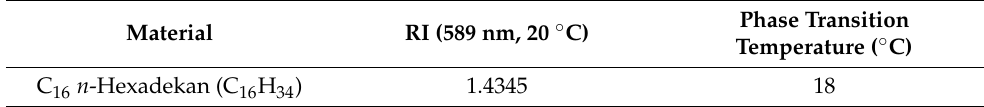
Table 1. The main parameters of hexadecane materials [25,31].